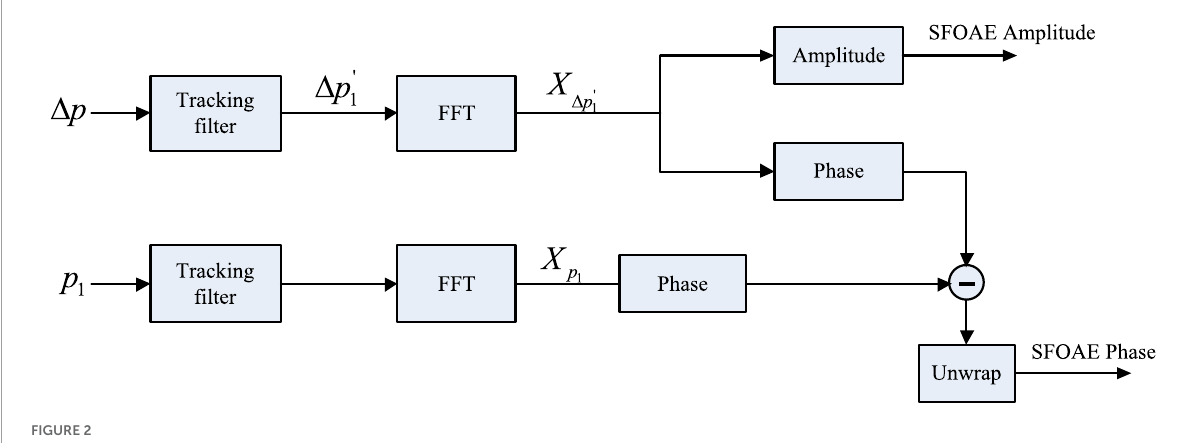
FIGURE2 Signal processing procedures to get the amplitude and phase of swept-tone stimulus frequency otoacoustic emissions (SFOAEs). The phase subtraction in the last step was to cancel the phase shifts introduced by the stimulus and the tracking